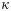
Altered phase space and modified connections.A Firing rates averaged across populations 5E and 6E and across areas for different stages from the original model (black) to iteration 4 (light gray) as a function of κ, predicted by the mean-field theory. B Relative changes in the indegree δKAB/∑B KAB between areas A, B in the first iteration. C Layer-specific relative changes δKln/∑n Kln in the connections within and between areas FEF and 46, for the first iteration. Populations are ordered from 2/3E (left) to 6I (right) on the horizontal axis and from 6I (bottom) to 2/3E (top) on the vertical axis as in panel D. D Relative changes in population-specific indegrees summed over target populations, ∑l δKln/∑l Kln, combined for iterations two, three and four.